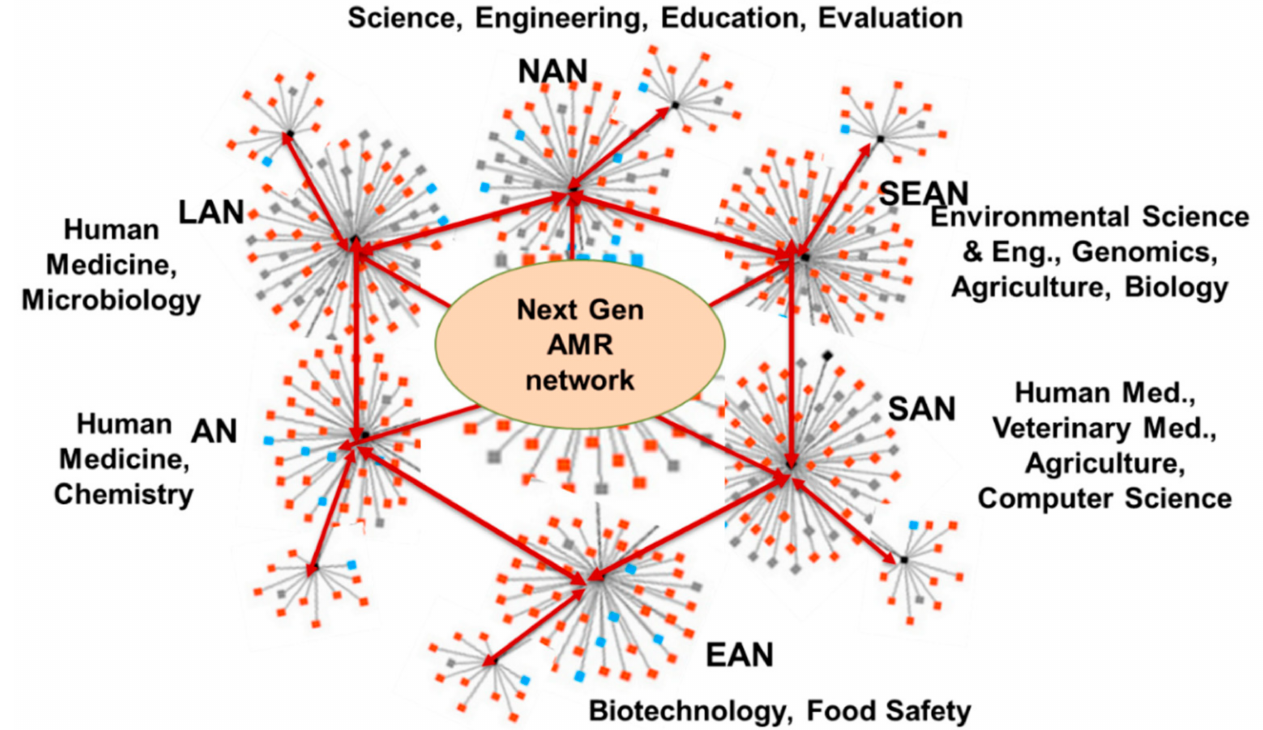
Figure 6. Next-generation AMR network. NAN = North American Network; LAN = Latin American Network; SEAN = Southeast Asian Network; SAN = South Asian Network; EAN = East Asian Network; AN = African